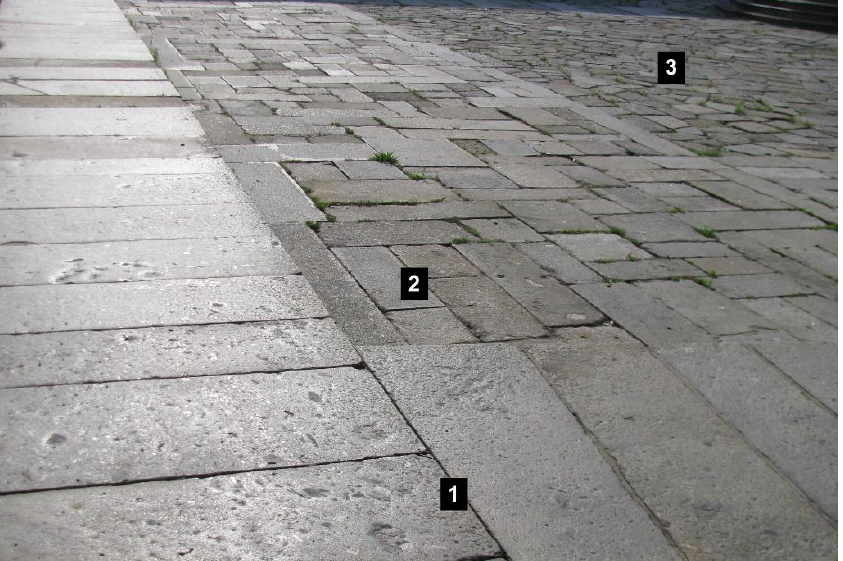
Figure 9. Illustration of referencing situation in pavements: regular disposition of geometrically regular stones in 1, geometrically regular stones disposed in a more uneven manner in 2 and irregularly shaped stones disposed in an uneven